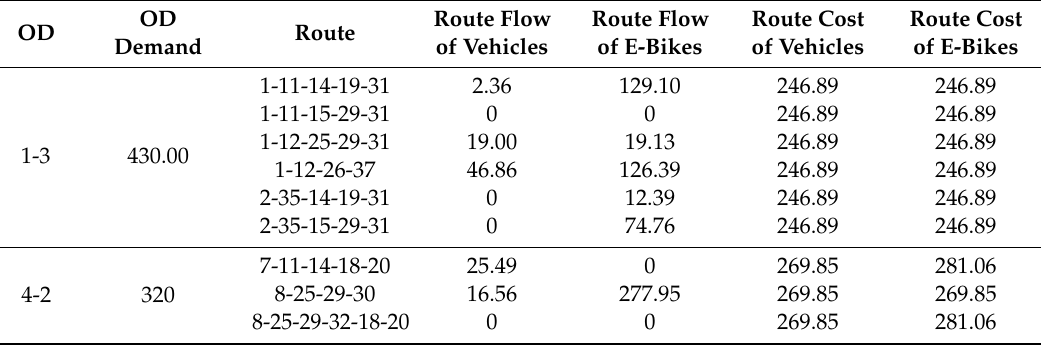
Table 9. Route flows of the NCP for the Nguyen–Dupuis